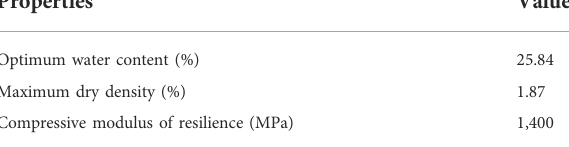
TABLE 3 Physical properties of the soil with 0.01% Huaxia No. 1.